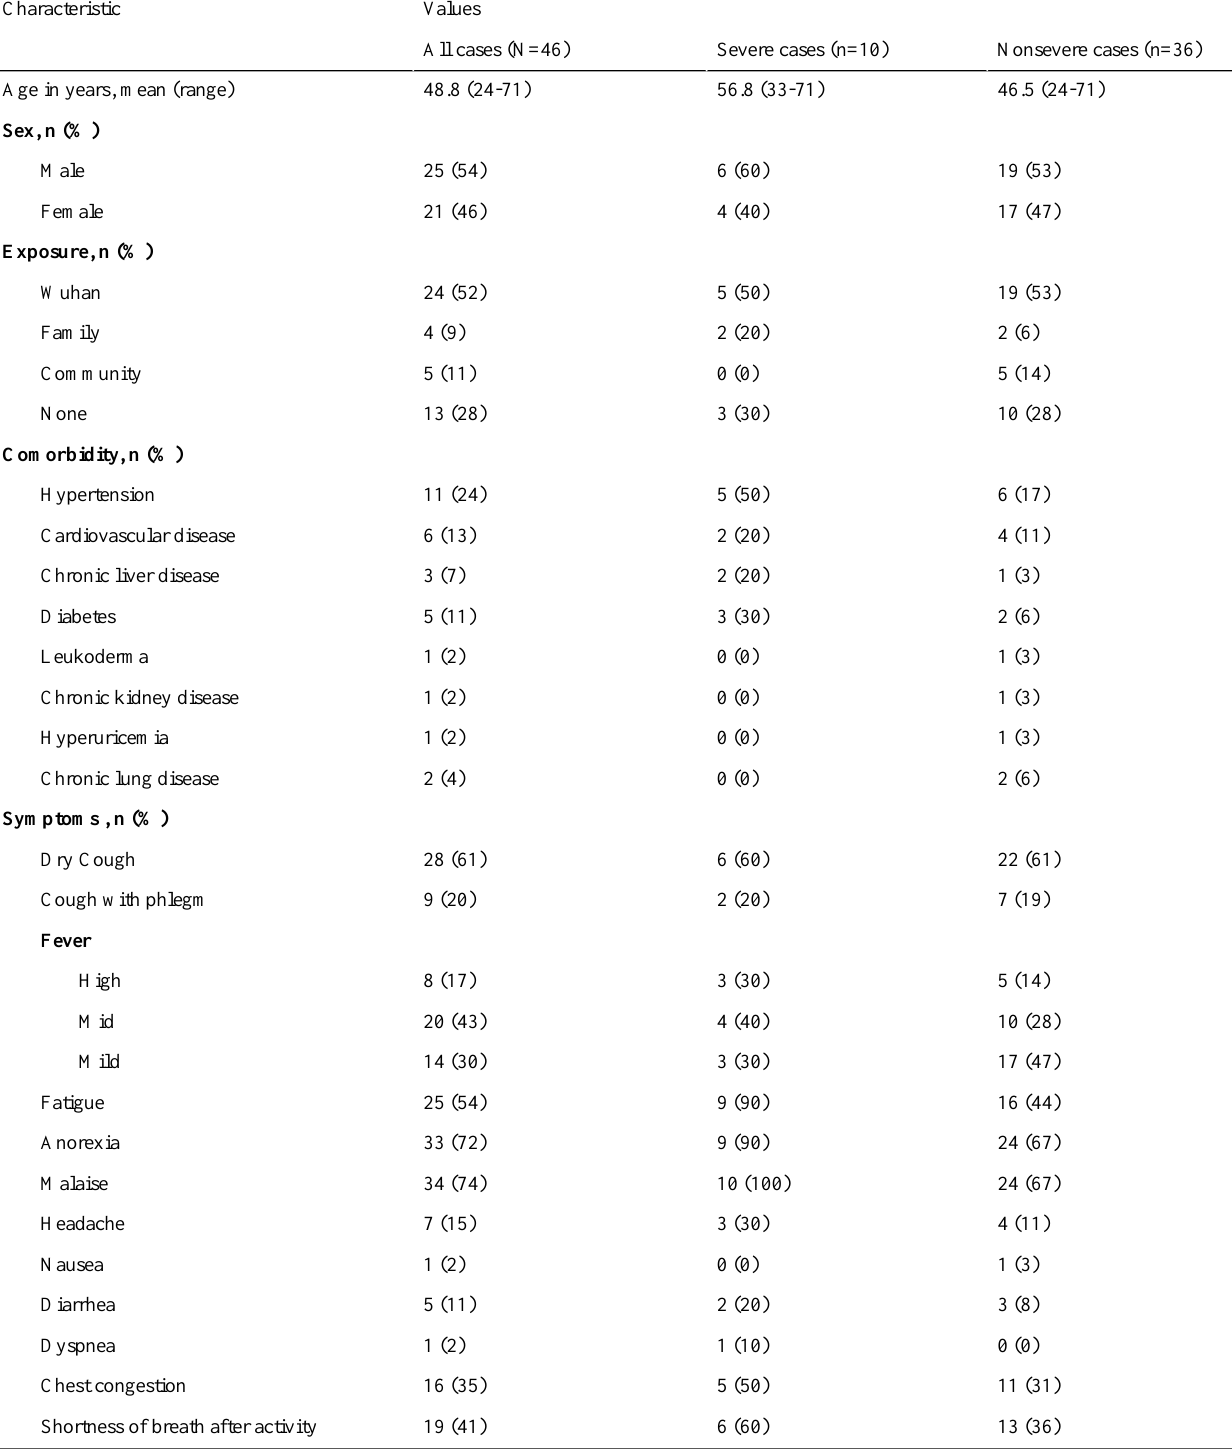
Table 1. Characteristics and symptoms of study patients.